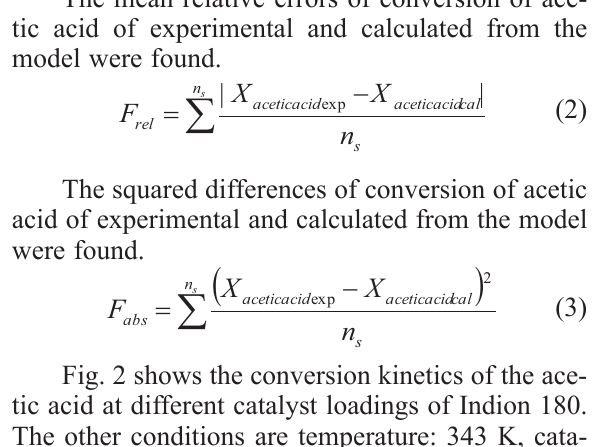
Fig. 2 shows the conversion kinetics of the ace- tic acid at different catalyst loadings of Indion 180. The other conditions are temperature: 343 K, cata- lyst size: 725 microns, agitation speed: 240 rpm.